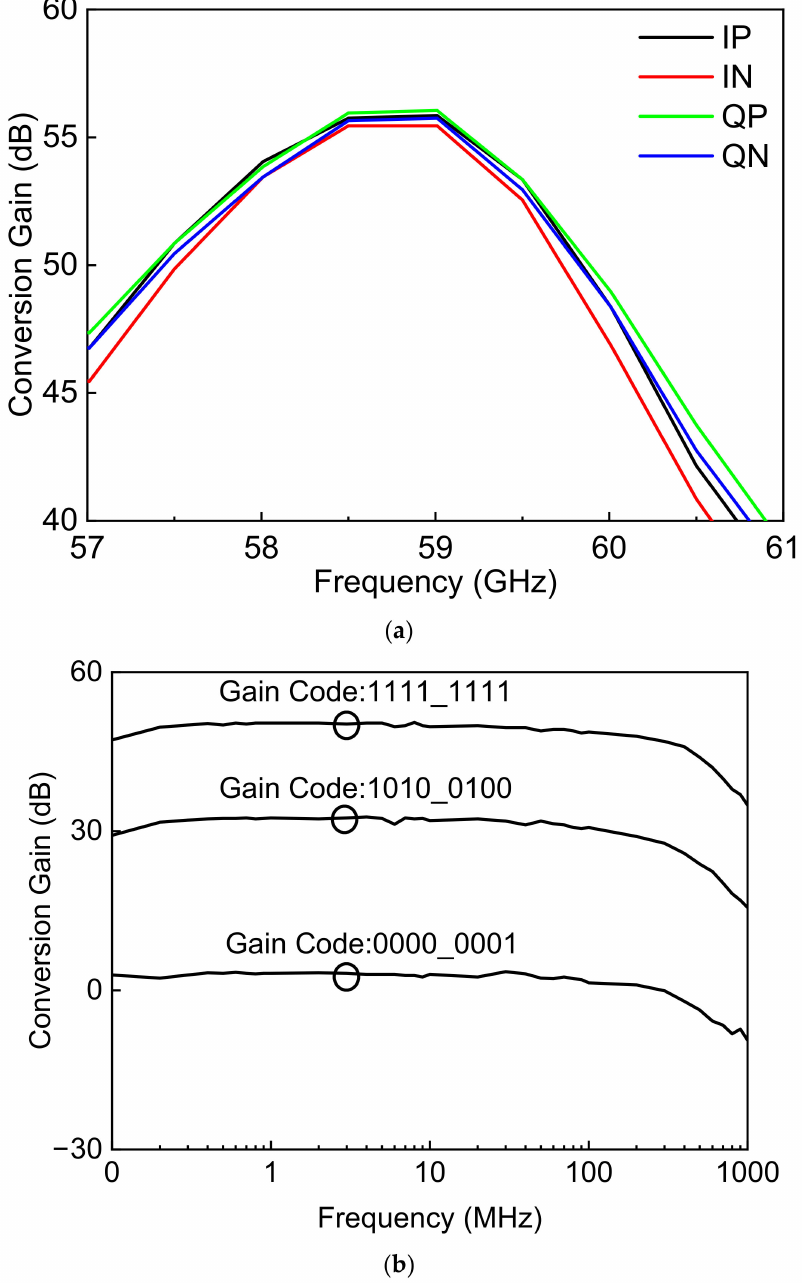
Figure 13. Measured ( a ) conversion gain versus RF frequencies at different IF ports (Gain code: 1111_1111), ( b ) conversion gain versus IF